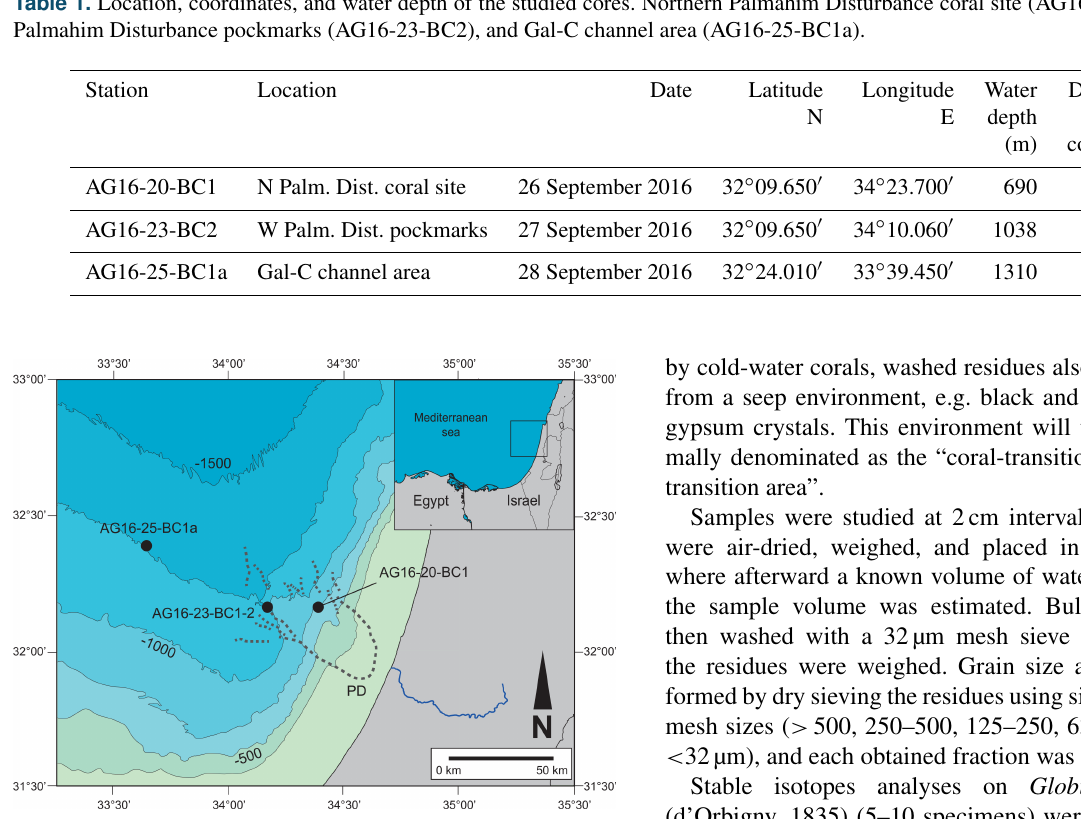
Table 1. Location, coordinates, and water depth of the studied cores. Northern Palmahim Disturbance coral site (AG16-20-BC1b), western